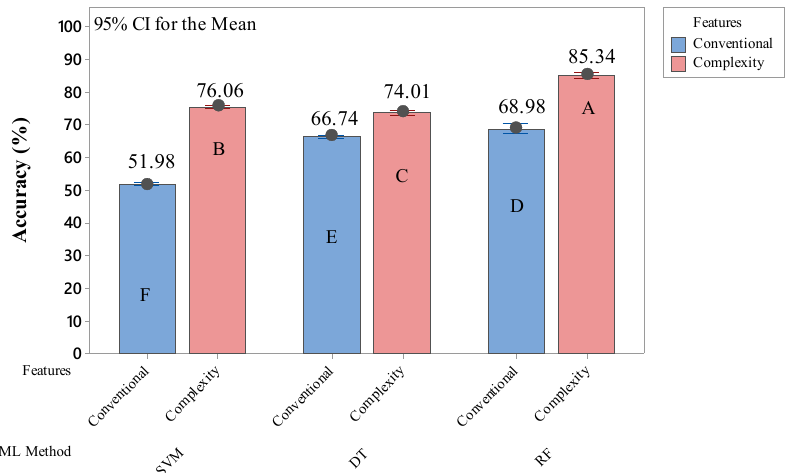
Figure 5. Accuracy comparison of AI models that are built using conventional and eye-movement complexity features. Means that do not share a letter are significantly different.